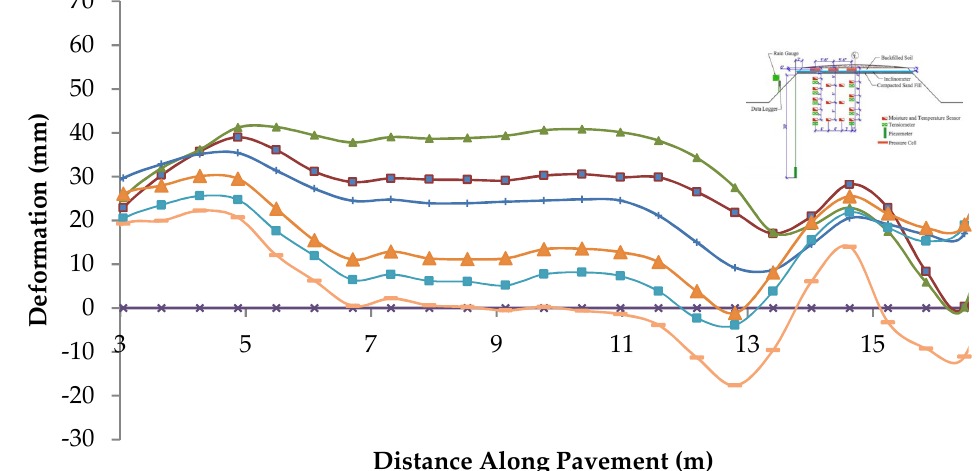
Figure 9. Variation of deformation along distance in central section in SH 342 site (from Inclinometer data).